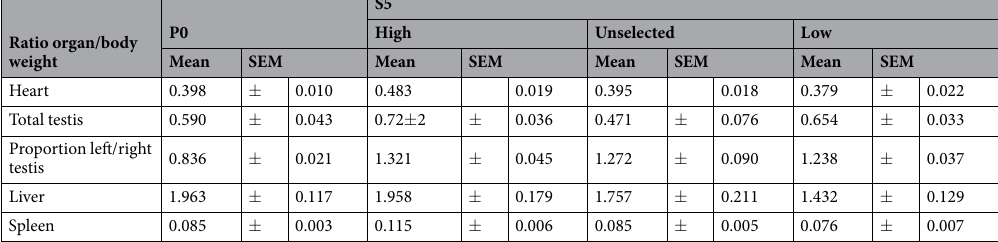
The relative sizes of heart, liver, spleen and testis in each selection line is summarized in Table 1. Within S5, S5 high animals had relatively larger hearts (corrected for body weight) than S5 unselected and S5 low animals (F 2.58 = 9.47; P < 0.001). They also had significantly larger relative heart size than the average P0 (F 1.85 = 18.72; P < 0.001). Males had significantly larger relative heart size than females in S5, (F 1.58 = 6.645; P = 0.012). S5 high had larger relative liver sizes than both S5 unselected and S5 low (F 2.57 = 4.41; P < 0.016). There were no differences in liver size between the average P0 and any of the selection lines in S5, but there was a sex effect within S5, with females having significantly larger relative liver sizes than males (F 1.57 = 239.28; P < 0.001). S5 high had the largest relative spleen size (F 2.58 = 9.39; P < 0.003). S5 high also had significantly larger spleens than the average P0 (F 1.85 = 27.58; P < 0.001). S5 high had significantly larger total testis weight than the other selection lines (F 2.32 = 6.92; P < 0.003). The proportion of right vs left testis did not differ between the selection lines within S5 but the average P0 proportion was significantly smaller than all the three lines of S5 (P0-S5 High F 1.40 = 126.1; P < 0.001; P0-S5 Unselected